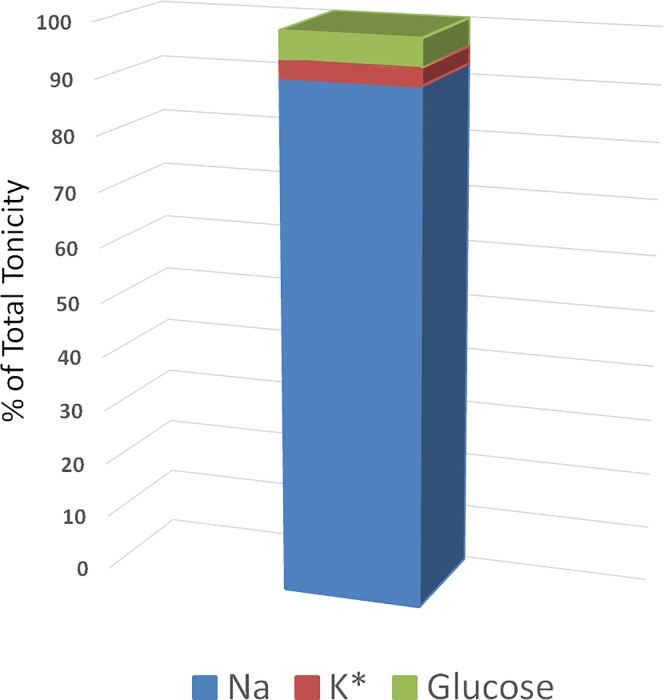
Contribution of measured effective osmoles to serum tonicity in insulin-treated diabetic dogs.Glucose (green bar) contributed 5% of effective osmoles to serum tonicity in insulin-treated diabetic dogs. Sodium (blue bar) provided the majority of effective osmoles and with potassium (red bar) contributed a combined 95% of effective osmoles to serum tonicity. For simplicity, osmoles contributed by sodium and its corresponding anions and by potassium and its corresponding anions are represented, respectively, as ‘sodium’ and ‘potassium’ in the figure.